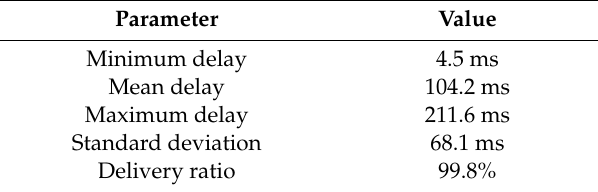
Table 1. Results of measurement of the authentication query delay and delivery